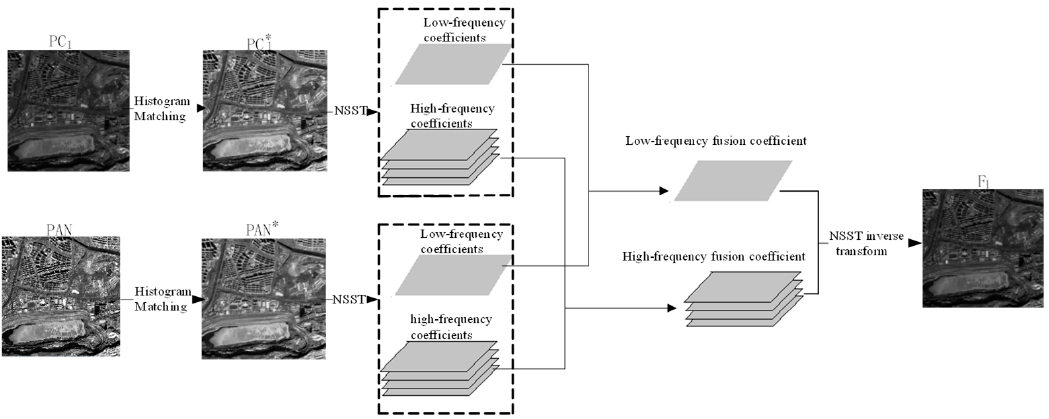
Figure 3. Fusion flowchart of PC1 and the PAN image using the NSST transform.